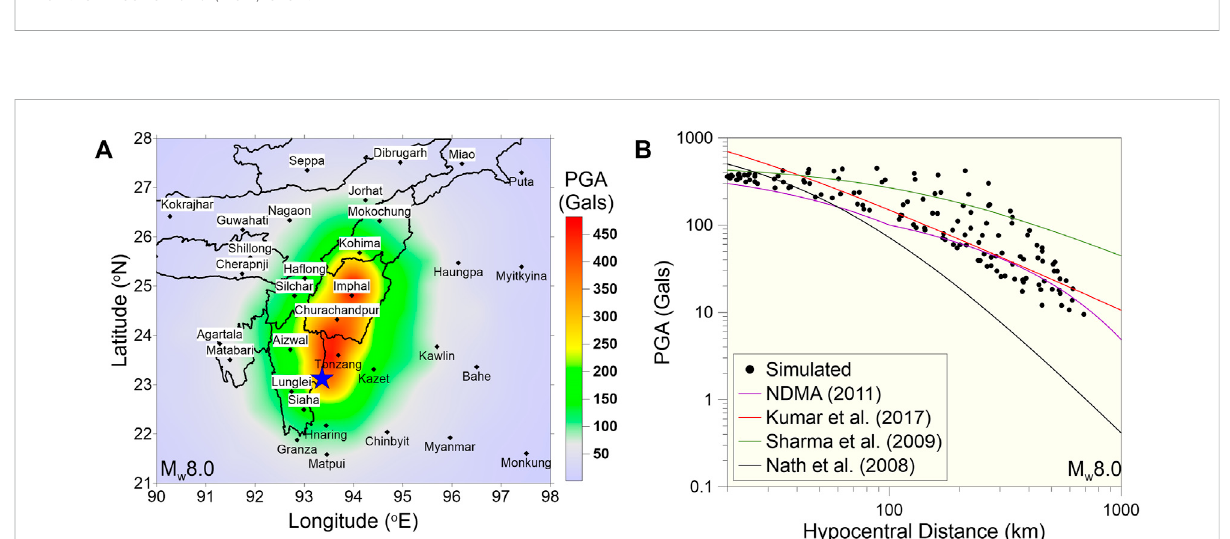
FIGURE 5 The plotdisplays (A) PGAdistributionfor afuture greatmagnitude event (M8.0) in thestudy area (B) acomparative plotbetween simulated PGA with different attenuation relations developed for the region.